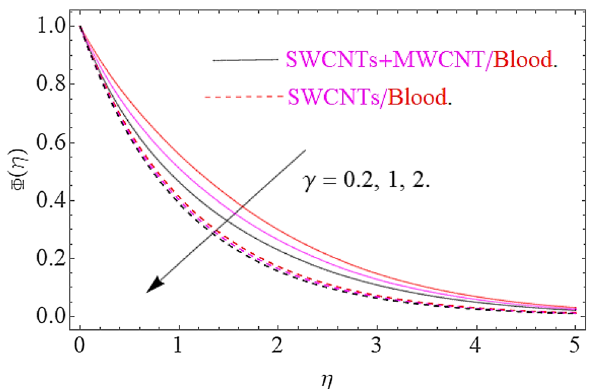
Figure 12. Influence of γ on �(η) .